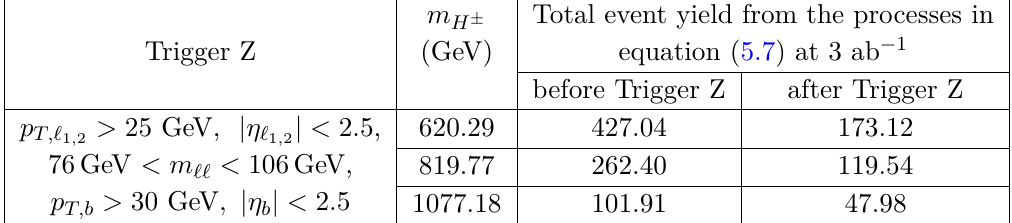
χ ± χ 0 in ‘‘ + LLCP category. e 1 2 e